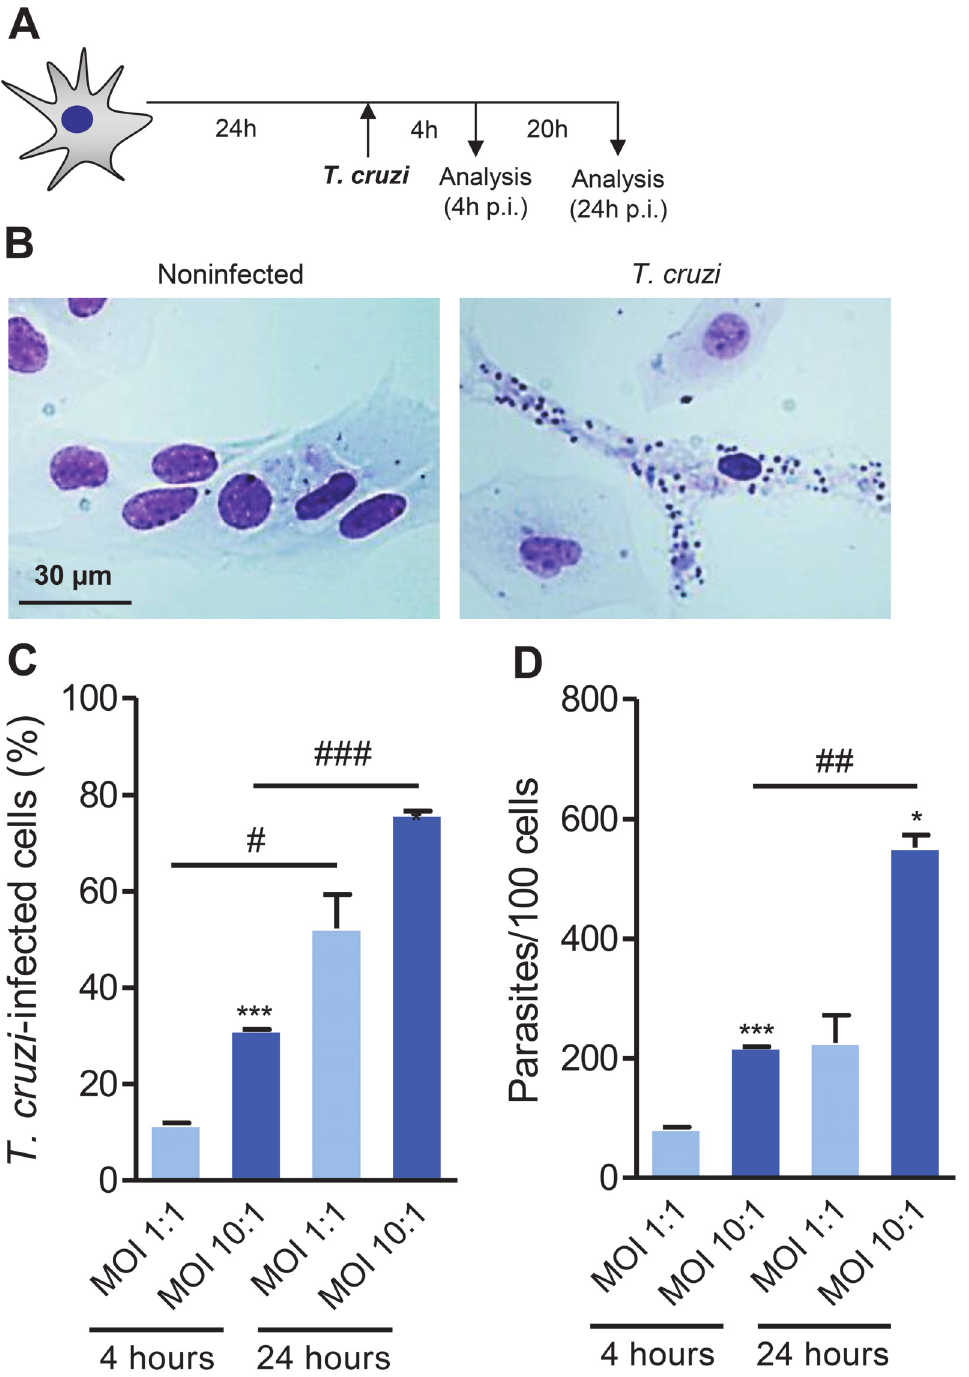
Fig 2. Astrocytes of murine CNS primary cultures are targets of Trypanosoma cruzi infection. (A) Experimental scheme showing that cultures of astrocytes were infected at MOI of 1:1 or 10:1 and analyzed 4 and 24 hours post-infection (p.i.). (B) Representative pictures of noninfected and T. cruzi - infected astrocytes at 4 hours of infection. (C) The percentage of infected cells (D) and the number of parasites per cells were analyzed. Data are presented as mean ± SEM of triplicates. * , p < 0.05 and *** , p < 0.001comparing MOI 1:1 with MOI 10:1 in each analyzed intervals; # , p < 0.05, ## , p < 0.01 and ### , p < 0.001 comparing 4 hours with 24 hours in each studied MOI.